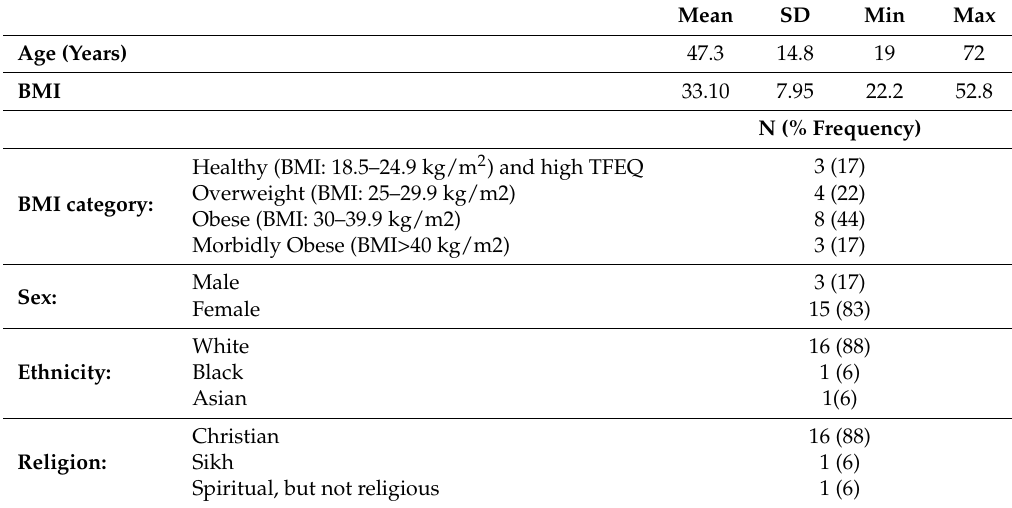
Table 2. Descriptive statistics of